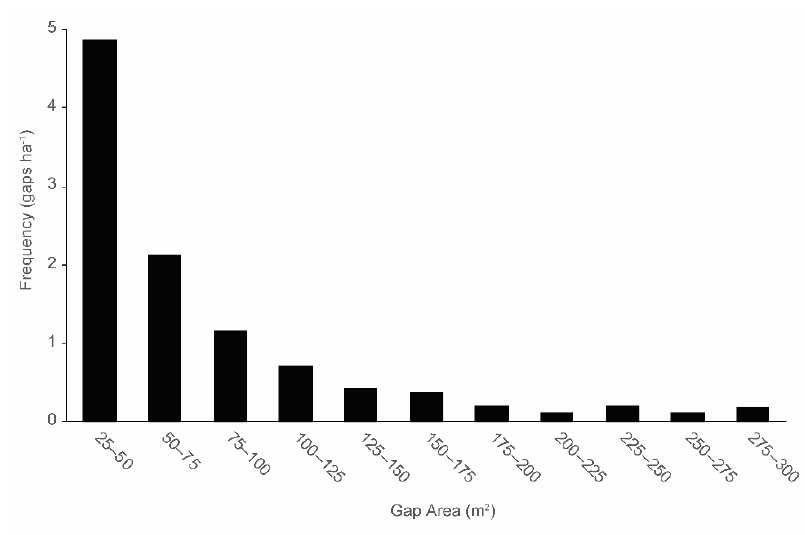
Figure 5. Map of a Pinus palutris dominated stand situated in Reed Brake Research Natural Area, Oakmulgee Ranger District, Talladega National Forest, Alabama, USA. The canopy height model displayed was derived from LiDAR data, with detected canopy gaps in blue. Black dots represent canopy gap sampling plots. Note that our maximum gap size threshold was 300 m 2 . The white area within the canopy height model is the 10 m buffer around abandoned skid trails.